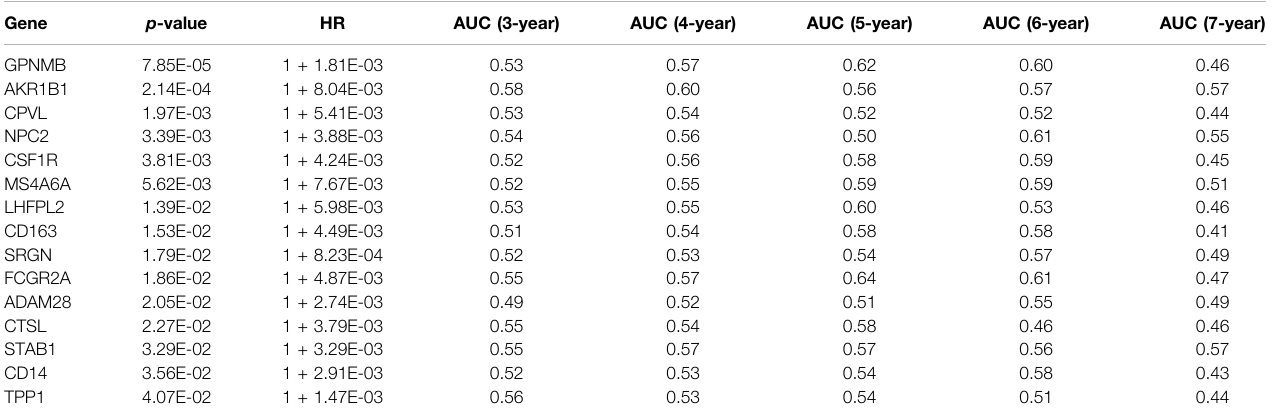
TABLE 1 | Univariate Cox regression models identify prognostic TNF α -derived genes. Gene p -value